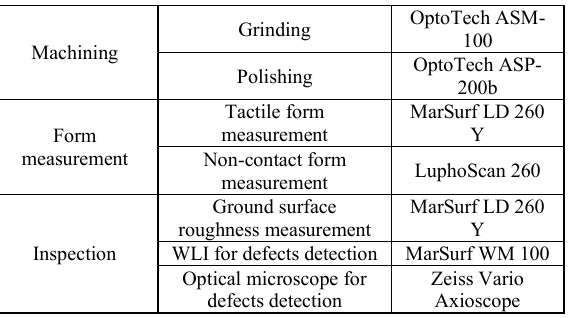
Table 1 . Equipment used in the experiment .